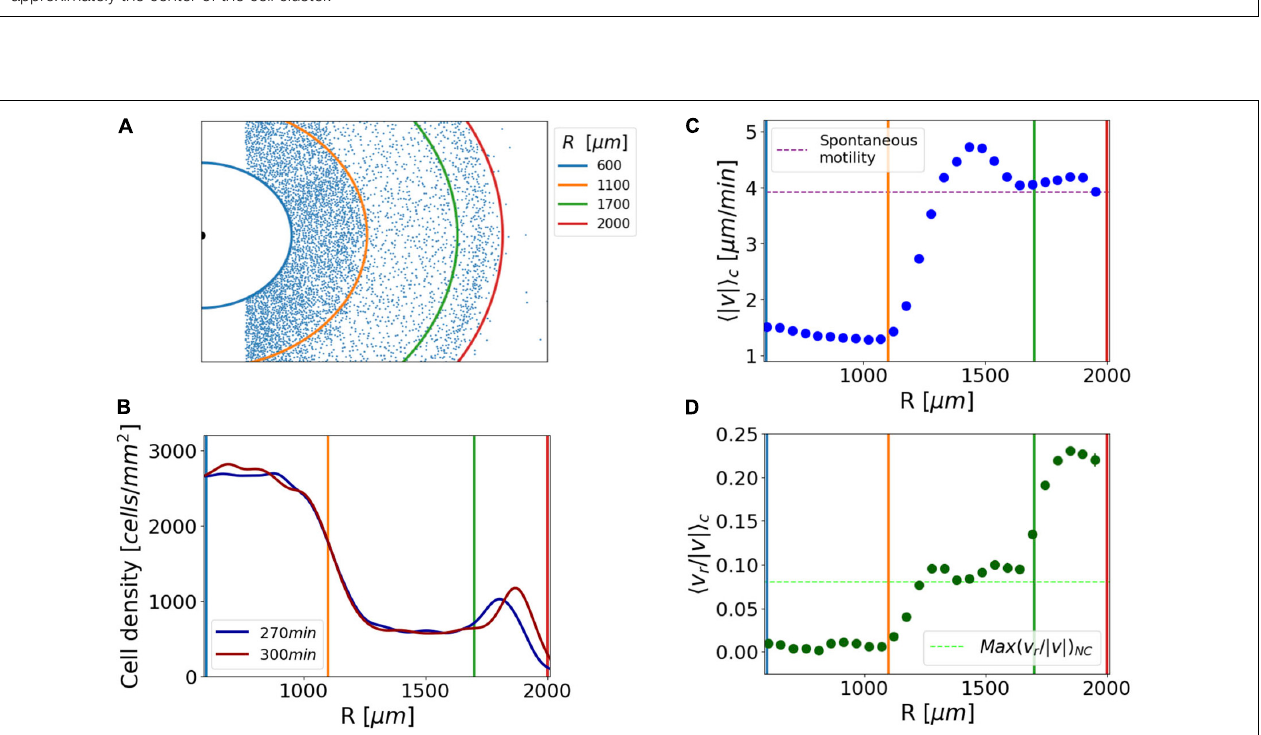
FIGURE 5 | Confined growing Dictyostelium cells displayed different motility profiles associated with areas of different cell densities. (A) Distribution of the tracked cells; continuous lines delimit three cell density regimes and serve as references for the plots that follow. (B) Cell density profiles did not change significantly in the observation time of 30 min, during which we performed cell tracking. (C) Cell average instantaneous speed < | v| > C as a function of their radial position R; the purple dashed line corresponds to the average speed measured for the WT spontaneous motility assay. (D) Average cosine of directions relative to the oxygen gradient direction < v r /| v| > C as a function of their radial position; as a benchmark for the directionality of the cells, we plot the maximum directionality measured in the not-confined cell cluster [Max( < v r /| v| > NC ) = 0.08], (green dashed line).